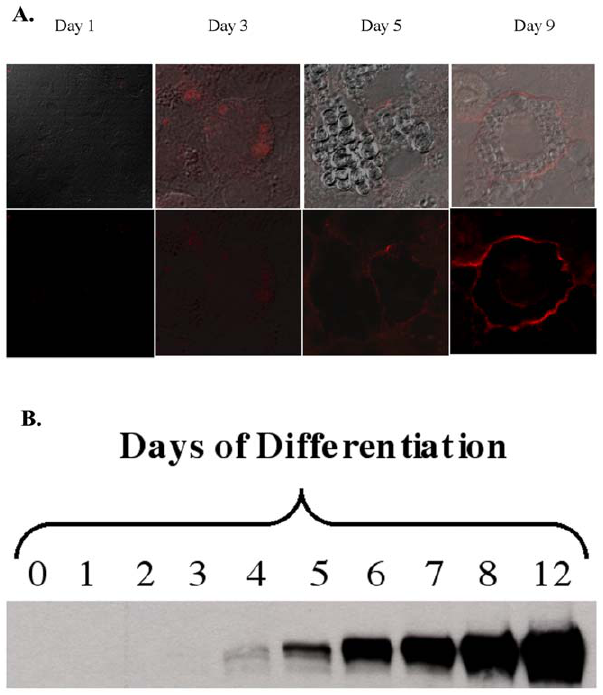
Figure 2. Visualization of AOC3 during murine 3T3-L1 adipo- cyte differentiation. A. Use of confocal fluorescence microscopy. Top, phase contrast image of adipocytes; bottom, overlay of immunofluo- rescence with phase contrast image (Anti-mouse AOC3 antibody courtesy of Sirpa Jalkanen). B. Differentiation, as detected by Western blotting using anti-mouse AOC3 antibody.